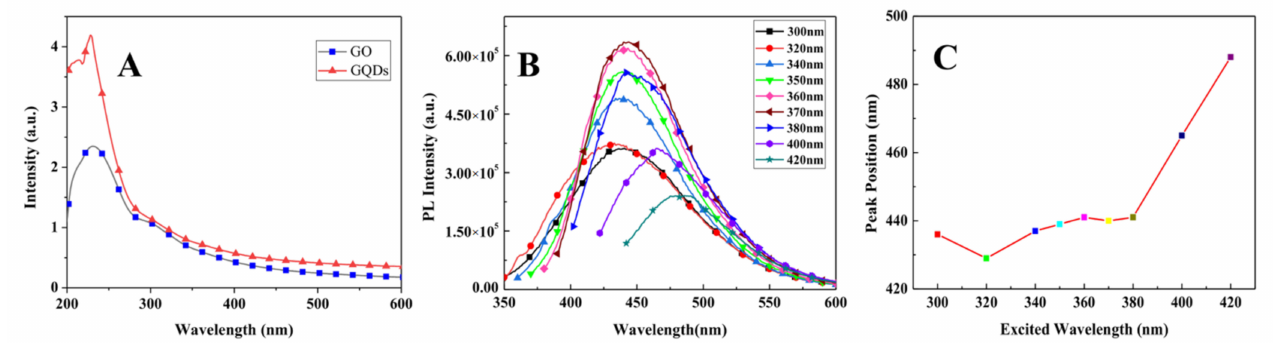
Figure 3. ( A ) UV-Vis absorption spectra of GQDs, GO is for comparison, ( B ) PL spectra of GQDs at different exciting wavelengths, and ( C ) PL peak positions changing with the excitation